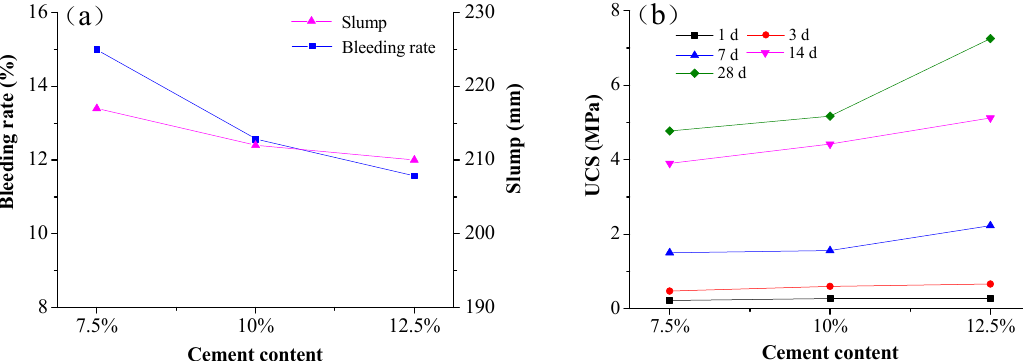
Figure 10. Effects of cement content on properties of filling material: ( a ) effects of cement content on transportation properties of filling material; ( b ) effects of cement content on mechanical properties of filling material.